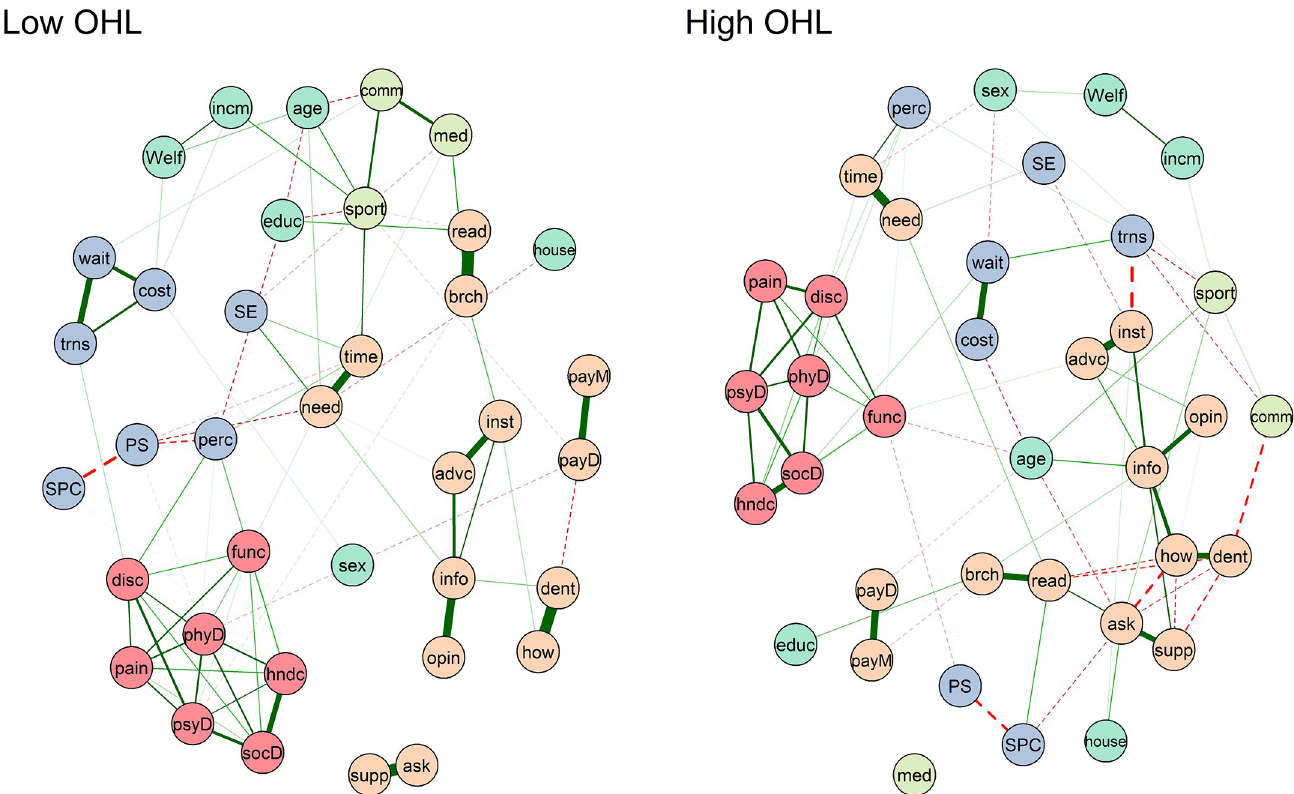
Fig 3. Centrality estimates for the HeLD-14 + covariates network, ordered by betweenness.